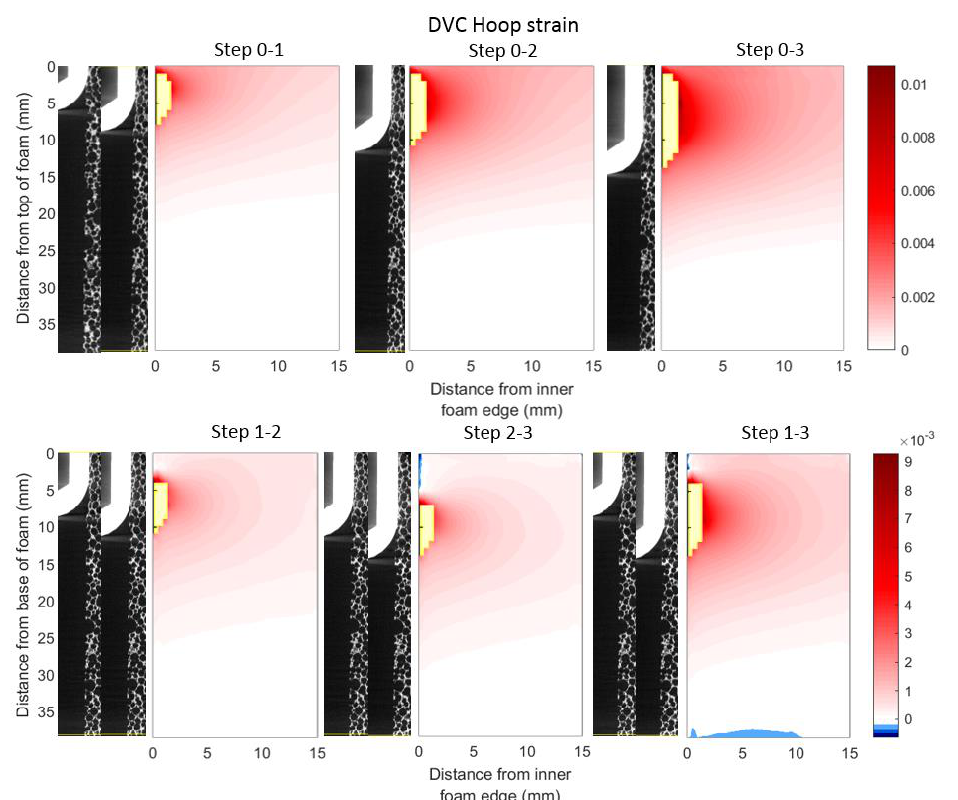
Figure 8. Hoop strain fields (averaged circumferentially) for each displacement step relative to reference scan and sequential scans. Like Figure 7, the top row shows the mean strain measured relative to the reference scan; the bottom row displaying that measured sequentially. Measurements with correlation coefficients below 0.9 have been excluded and their spatial locations are shown in yellow. Note change of strain scale.